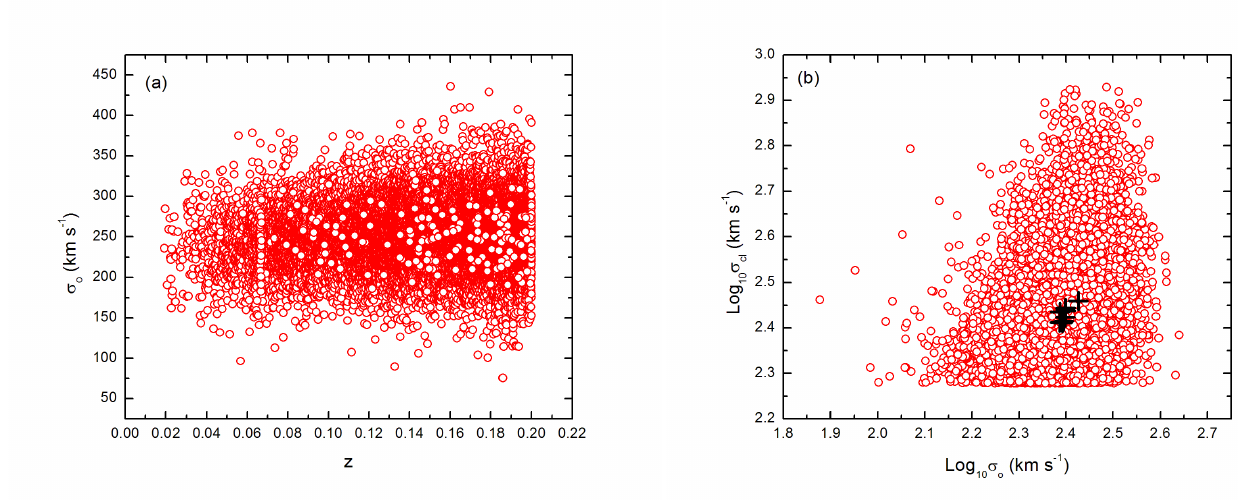
Fig. 5 σ o of BCGs in r -band with respect to (a) redshift and (b) σ cl of host clusters and groups. Error bars represent the average values of log 10 σ cl for log 10 σ o bins with